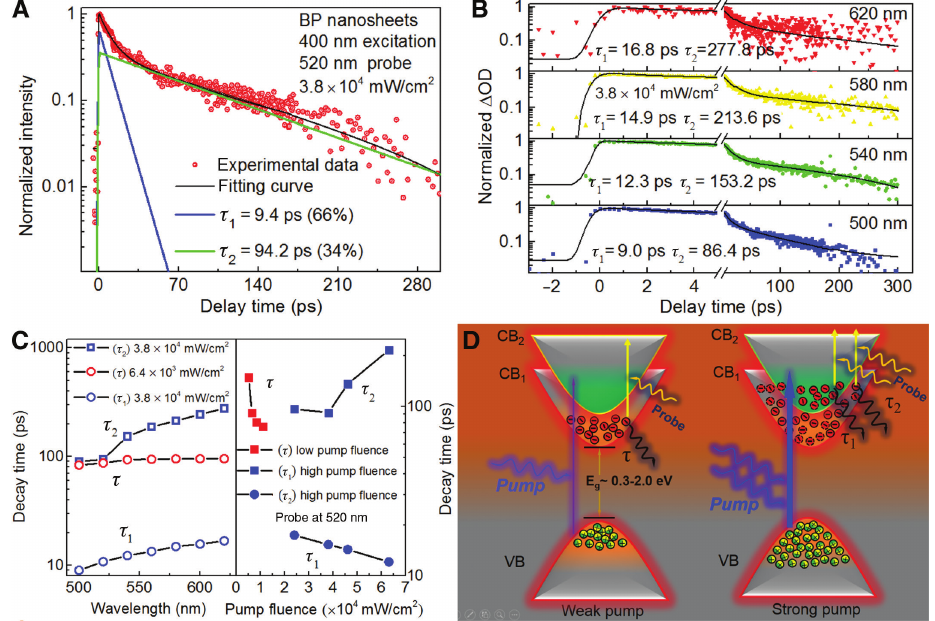
Figure 3: Comparison of the carrier dynamics between low pump fluence region and high pump fluence region for pump wavelength at 400 nm. (A) Transient absorption (TA) (red dot) signals measured with pump wavelength at 400 nm (3.8 × 10 4 mW/cm 2 ) and probe wavelength at 520 nm, fitted with the double-exponential function (black line). The blue line and green line represent the faster decaying process and the slower decaying process, respectively. (B) Carrier dynamics at different probe wavelengths (500 nm, 540 nm, 580 nm, 620 nm) with 400 nm pump at a fluence of 3.8 × 10 4 mW/cm 2 . (C) Left panel: probe wavelength-dependent lifetime (pump at 400 nm) at low fluence (6.4 × 10 3 mW/cm 2 , red circle) and high fluence (3.8 × 10 4 mW/cm 2 , blue square for τ ). Right panel: pump fluence-dependent carrier lifetimes in the 2 low fluence (red square) and high fluence (blue square) regions. (D) Schematic illustration of the subband structure of black phosphorus (BP) nanosheets and the carrier dynamics (with 400 nm laser as pump) at the weak pump fluence (left) and the strong pump fluence (right) condition,